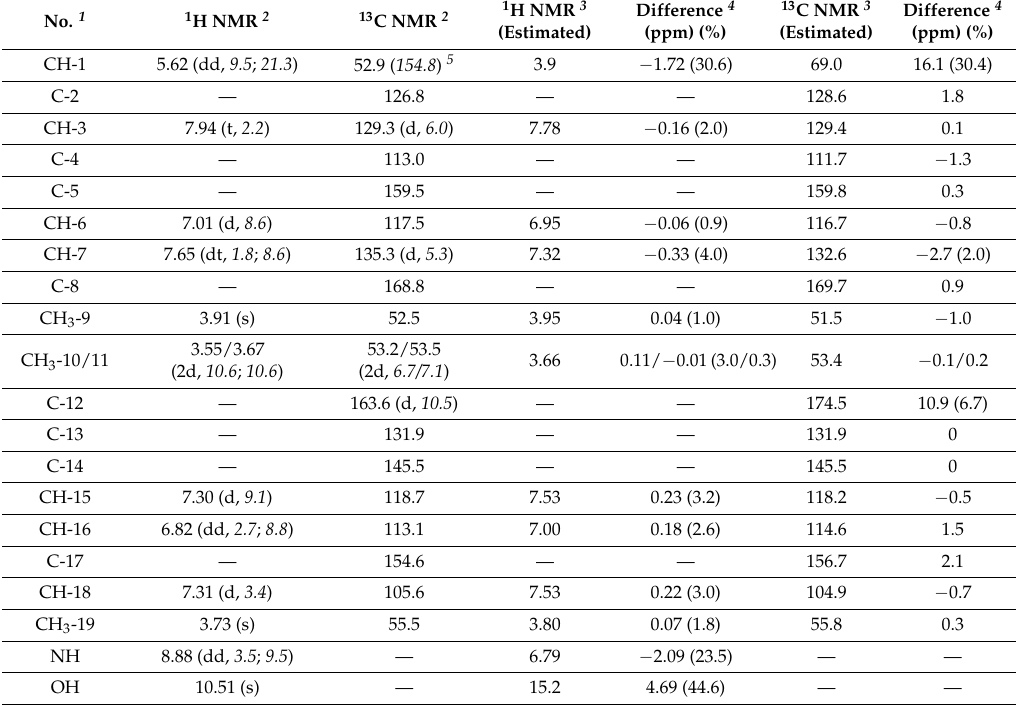
Table 1. Assignation of proton and carbon nuclear magnetic resonance (NMR) signals related to compounds 2 .